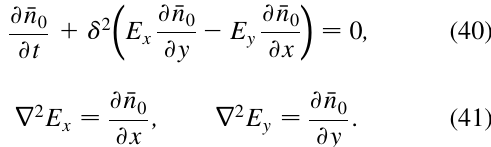
FIG. 4. Velocity field r gated density distribution. To compare with figures in Refs. [3,18], the beam’s transport direction is along the negative y